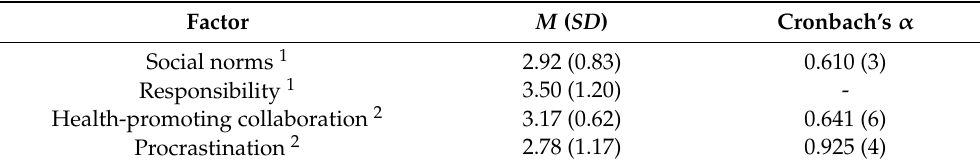
Table 2. Descriptive statistics of the influential